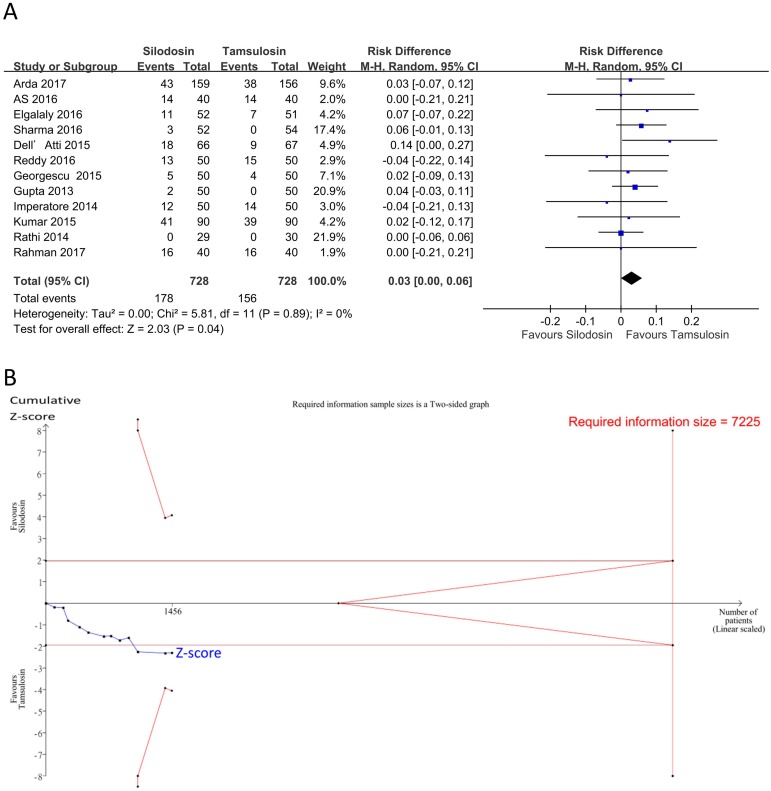
Forest plot and trial sequential analysis for total adverse events.A: Forest plot. RD, risk difference; CI, confidence interval. B: Trial sequential analysis assessing the effect of silodosin versus tamsulosin on total adverse events. The risk of a type I error was maintained at 5% with 90% power. The variance was calculated from data obtained from trials included in this meta-analysis. A clinically meaningful intervention effect was set to a 15% relative risk reduction based on the assumption of a 21.4% proportion of the control group.